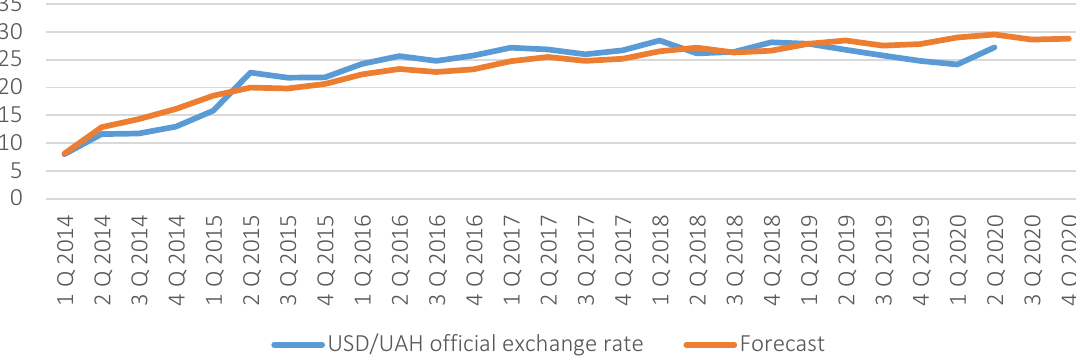
Figure B1. USD/UAH official exchange rate forecast, 3rd and 4th quarters of 2020 (additive model)